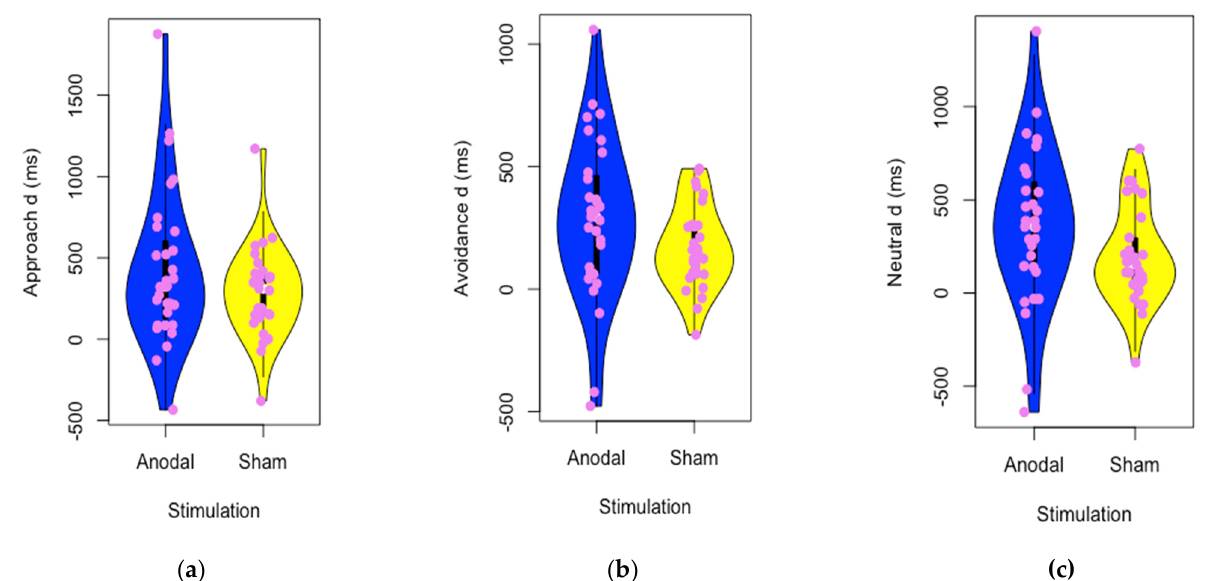
Figure 2. Distribution of speed reading improvement for tDCS conditions in the three types of sentences: approach ( a ), avoidance ( b ) and neutral ( c ).